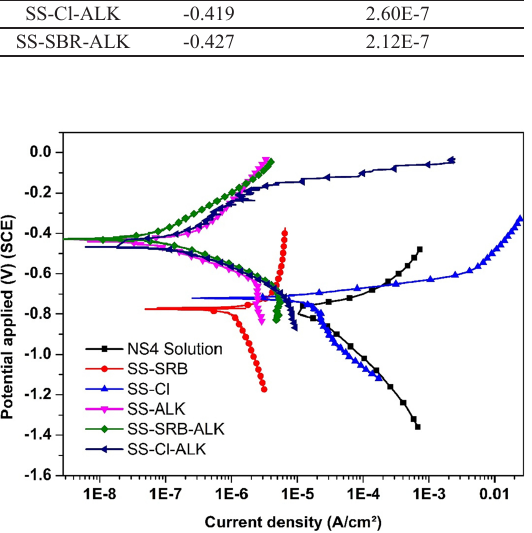
Figure 7. Polarization curves of API X65 steel in synthetic